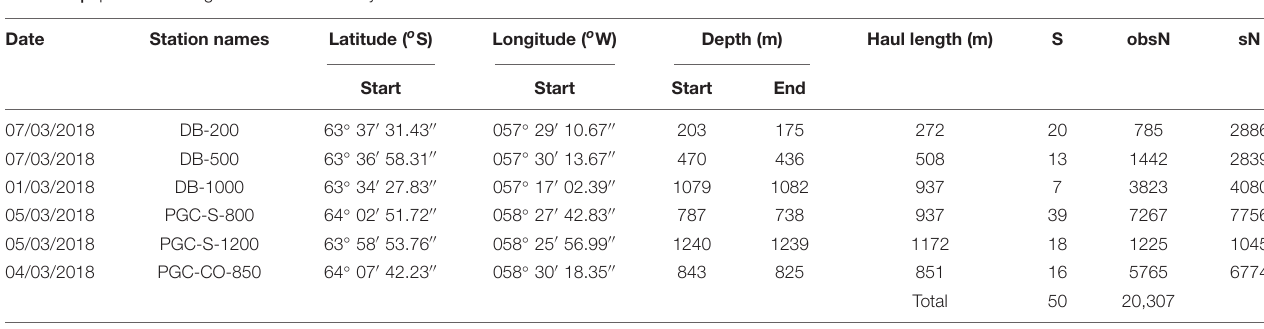
FIGURE 1 | Location of stations within the study area. (A) The western Weddell Gyre region including the Weddell Sea and South Orkney Islands. DB, Duse Bay; PGC, Prince Gustav Channel; PB, Powell Basin; swVK, southwest of Vestkapp; HB, Halley Bay; wWS, western Weddell Sea; KN, Kap Norvegia. (B) The Prince Gustav Channel area. S, South; CO, Cape Obelisk. TABLE 1 | Epibenthic sledge station and diversity